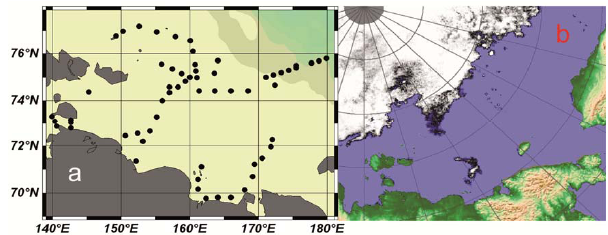
Fig. 2. Map with station positions in the ESS (a) and sea ice coverage on 7 September 2008 (b), Spreen et al. (2008); http://www.iup.uni-bremen.de:8084/amsr/amsre.html.